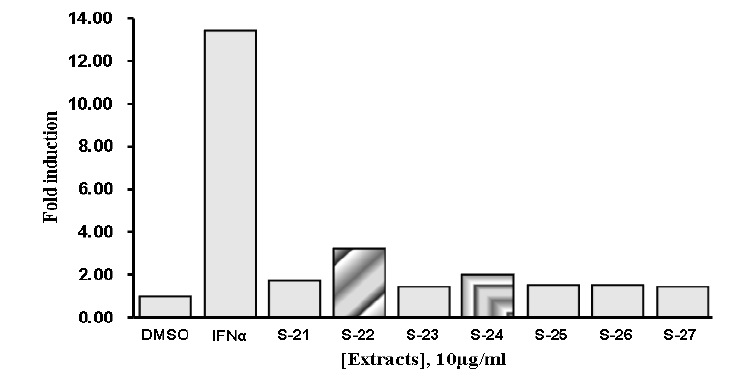
Fig. 1. IFN-like activity extracts of some mushrooms grown in